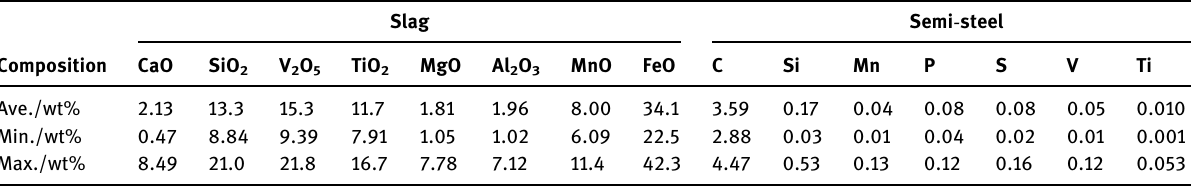
Table 4: Compositions of slag and semi - steel in the V - recovering BOF